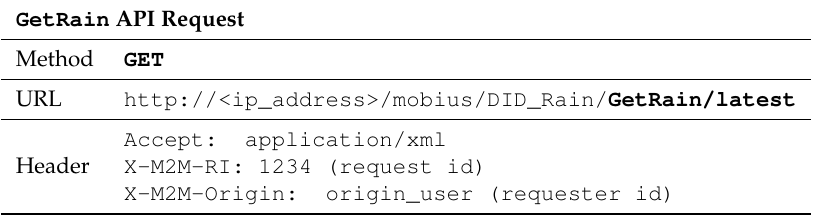
Table 3. An example of the GetRain API request to retrieve the latest value measured.